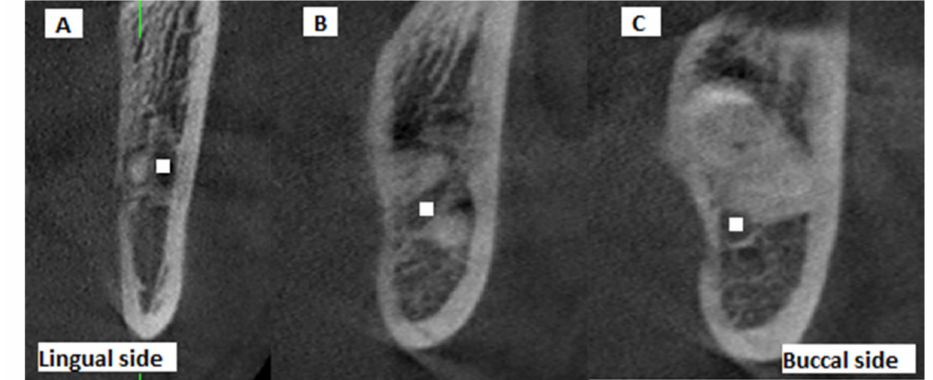
Figure 3. Cross-sectional CBCT views showing the buccolingual position of the IMTM apex relative to the MC: ( A ) buccal, ( B ) inter-radicular, ( C ) lingual (white squares: center of mandibular